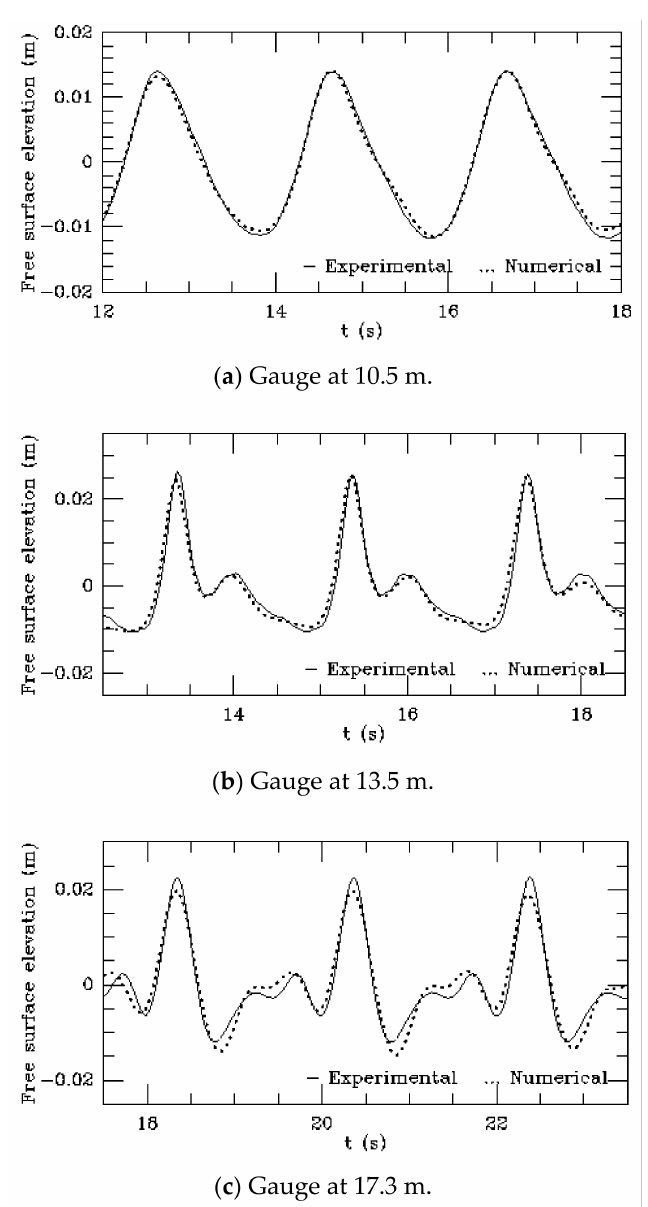
Figure 6. Periodic wave propagating over a bar (as shown in Figure 4). Free surface evolution at three gauges installed at ( a ) x = 10.5 m, ( b ) x = 13.5 m, and ( c ) x = 17.3